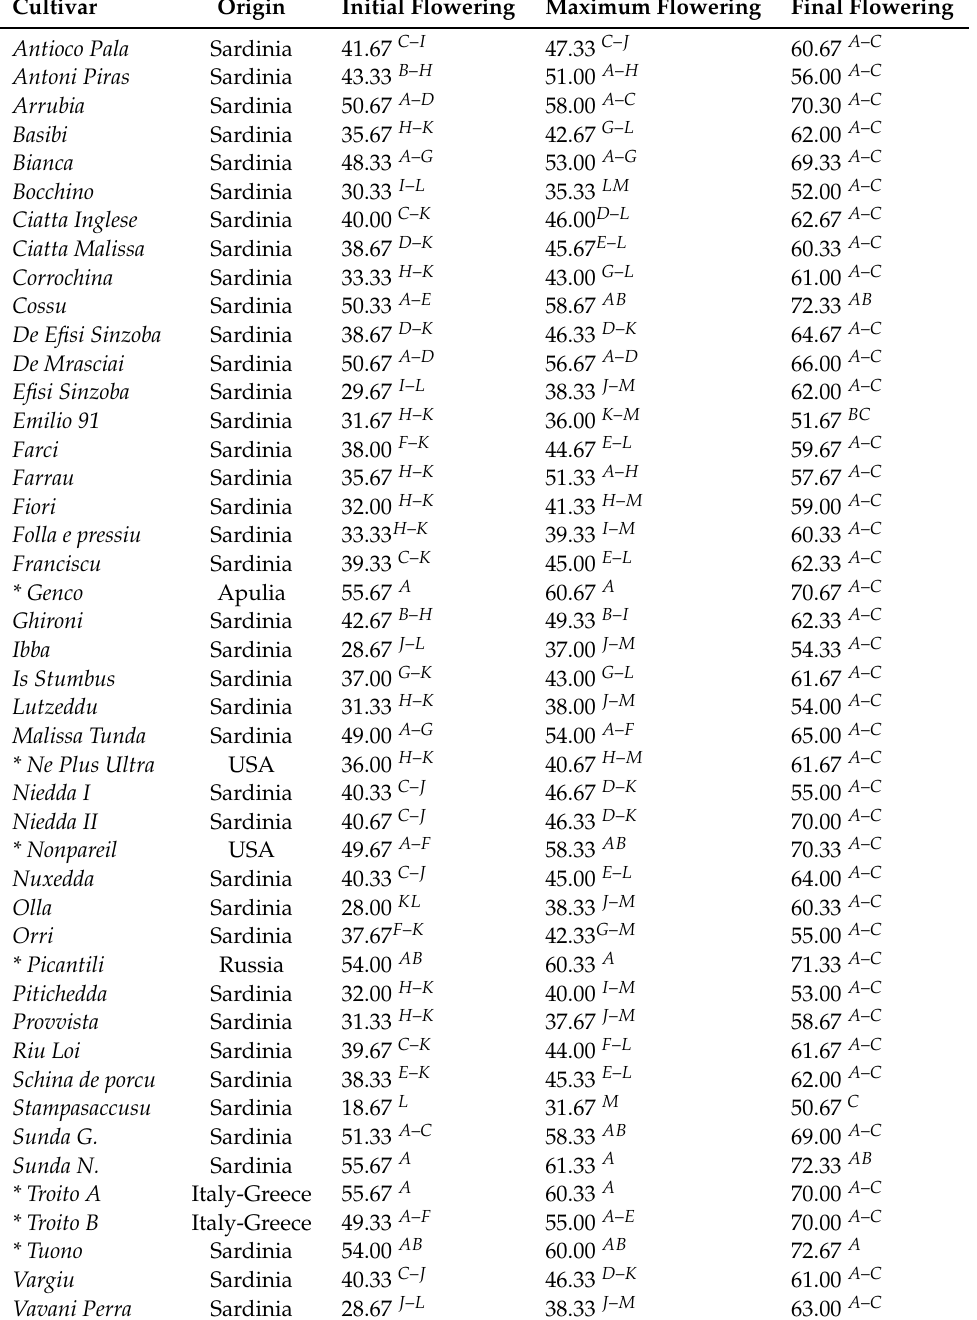
Table 1. Flowering traits and origin of analyzed cultivars. The names of reference cultivars are preceded by an asterisk. (The capital letters represent Tukey–Kramer (TK) groups at p < 0.05. Cultivars sharing at least one TK symbol are not significantly different for the trait in the